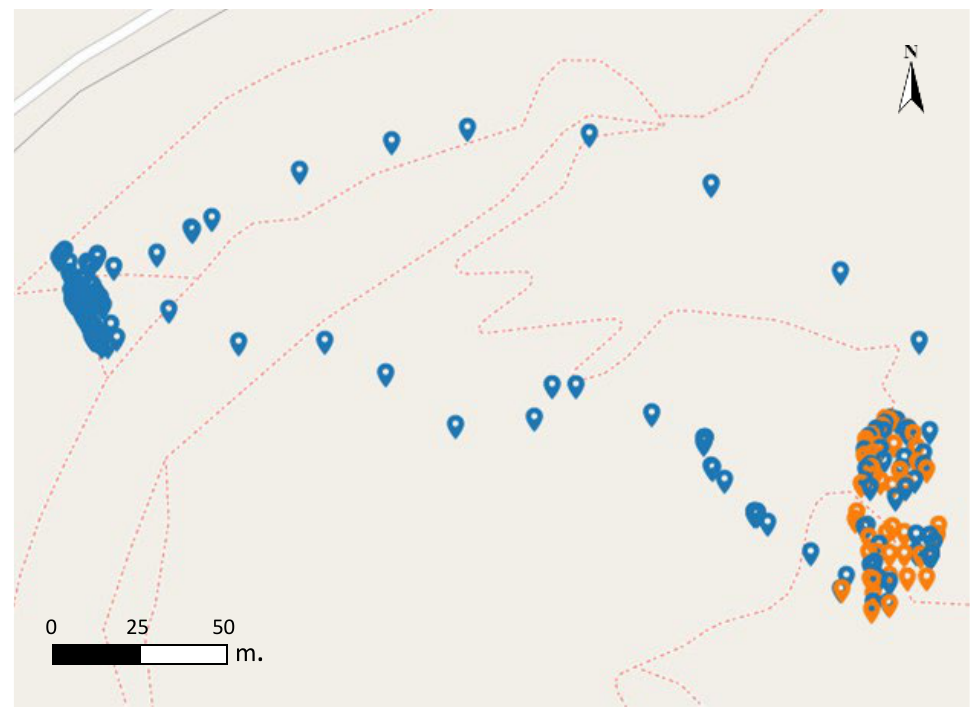
Figure 13. Trajectory visualization of raw (blue) and recording (orange) positions. Each of the recording positions of a trajectory can be selected from the visualization (Figure 13). The selected recording position is passed to a graph visualization, which pro- vides information about the recording events that occur in the selected position. In Figure 14, a graph visualization is provided that displays the results of a Cypher query (Appen- dix B.3), including the nodes of the recording event, the recording position, the trajectory, and the location point, as well as the record produced by the recording event and the two POIs that the record captures. Hovering over each node enables a tooltip that displays the node attributes. The selection of a record in the graph visualization provides the record source path to the record preview report, which displays the record.